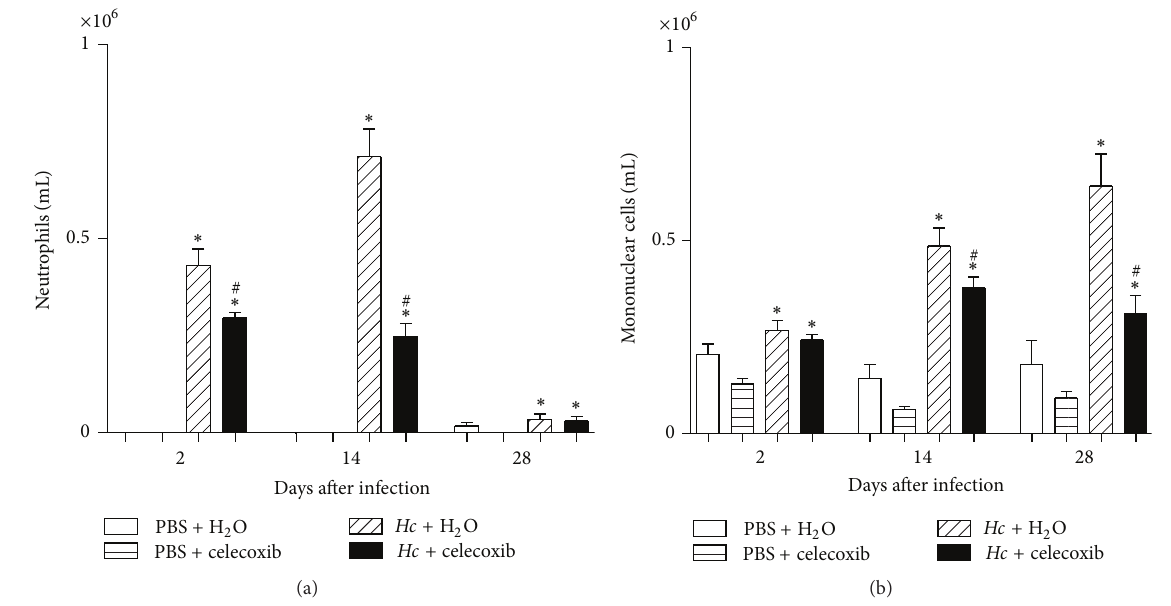
Figure 4: The inhibition of endogenous prostaglandin synthesis alters BALF leukocyte numbers during H. capsulatum infection. BALF cells were obtained from mice after i.t. injection of PBS or sublethal H. capsulatum infection and daily p.o. administration of water or celecoxib (1mg/kg/0.5mL).(a)Neutrophilsand(b)mononuclearcells.Thecellswereenumeratedandidentifiedaftercytospinpreparationandpanoptic staining. The data are presented as the means ± SEM representative of three independent experiments (𝑛 = 5 - 6) . One-way ANOVA (Tukey’s multiple comparison test) was used. ∗ PBS + H 2 O versus Hc + H 2 O or versus Hc + celecoxib; # Hc + H 2 O versus Hc + celecoxib 𝑃 < 0.05